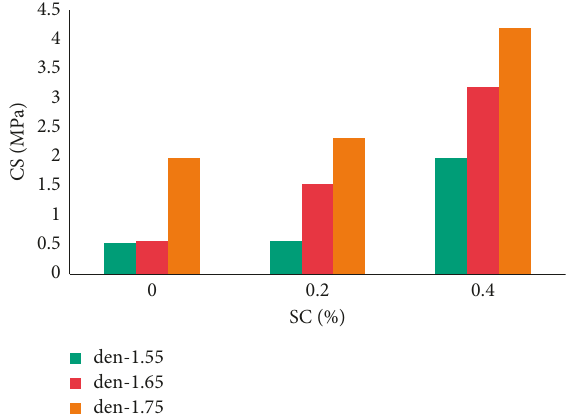
Figure 5: The relationship between the compressive strength of the sample and the solid content of the composite nano-calcium